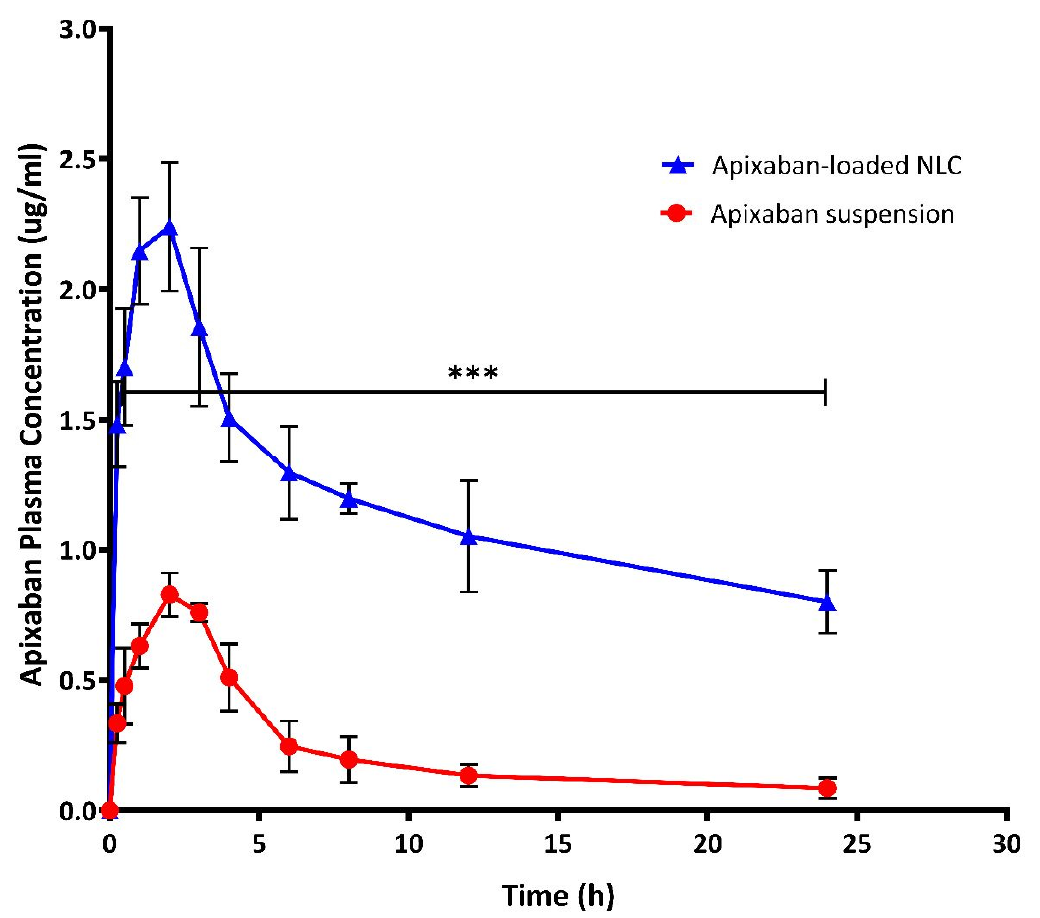
Figure 5. Plasma concentration of apixaban (Apx) after oral administration of 60 mg/kg of Apx- NLC and free Apx suspension (mean ± SD, n = 6). Note: *** significant effect at p -value < 0.001 at all-time points. Table 5. Pharmacokinetic parameters of Apixaban-loaded NLC and free Apixaban suspension